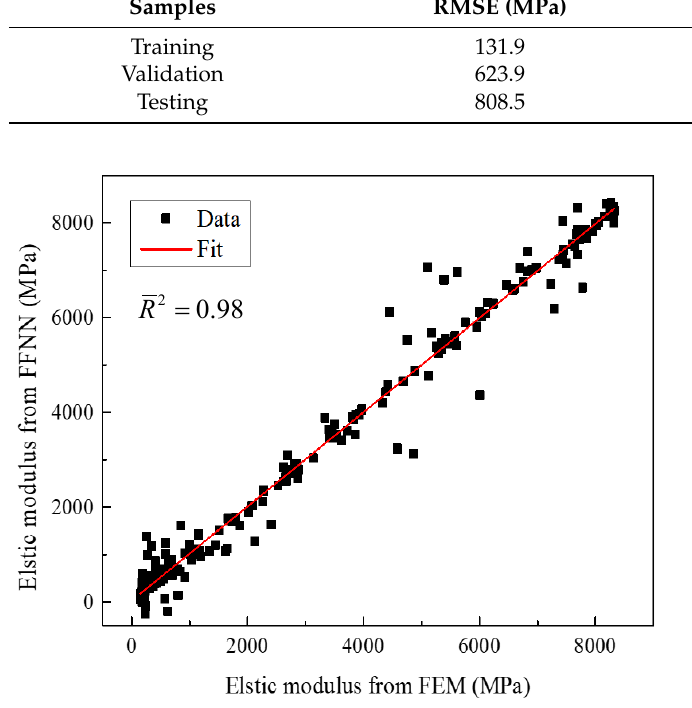
Figure 13. Linear regression of the elastic modulus between those from the FFNN and FEM.